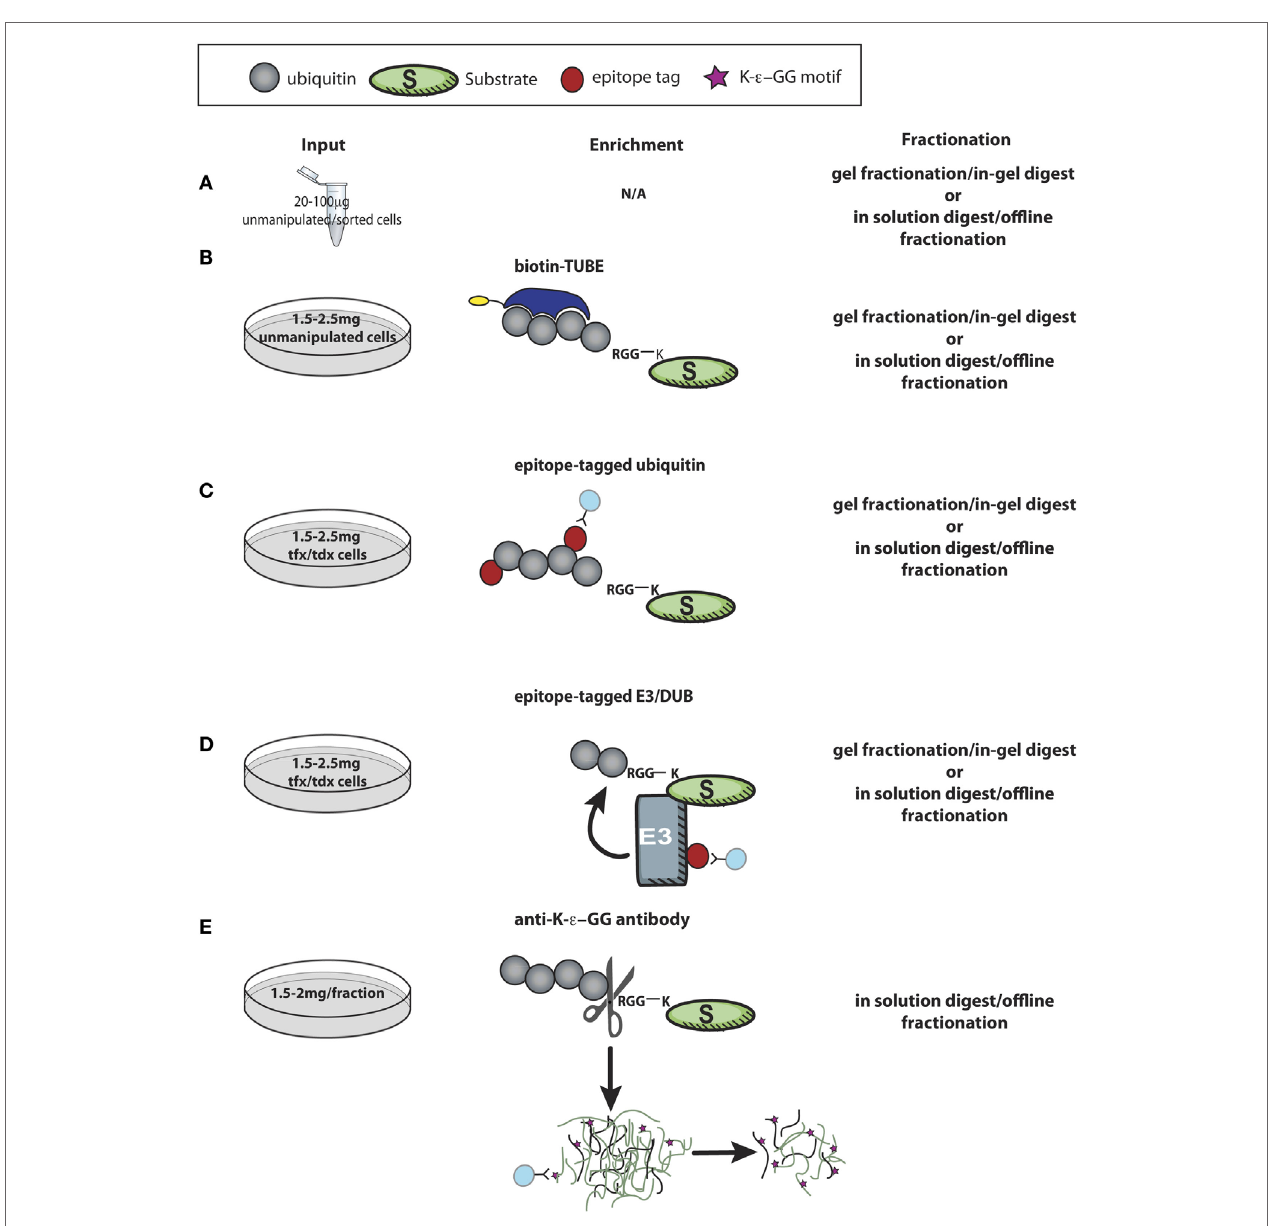
FiGURe 3 | Proteomic approaches to discover new targets of ubiquitin enzymes in T cells . (A) Using minimal protein from recovered after lysing unmanipulated primary cells, LC-MS/MS analysis of control and experimental cells is useful to screen for relative expression of thousands of proteins, allowing further pathway analysis and combination with other datasets to identify possible targets of ubiquitylation. (B,C) Enrichment of polyubiquitin chains using a tandem ubiquitin-binding entities (TUBEs) by immunoprecipitation of epitope-tagged ubiquitin identifies thousands of proteins that are either directly ubiquitylated or involved in ubiquitin complexes with relatively minimal cellular manipulation, and ~1–2 mg of protein input. (D) More challenging in primary cells is expression of tagged E3 ligases or DUBs in primary cells to immunoprecipitate substrates, which may be bound only transiently and with low affinity to the enzyme of interest. (e) K- ϵ -GG peptide immunoprecipitation, perhaps the most direct proteomic approach to identify ubiquitylation, is challenging due to the large amount of starting material required (0.5–1 mg peptide/fraction). These approaches, and combinations there-of, hold great promise for future studies, both for hypothesis generation and investigations into molecular mechanisms of action for specific ubiquitylation enzymes. tfx = transfected, tdx =